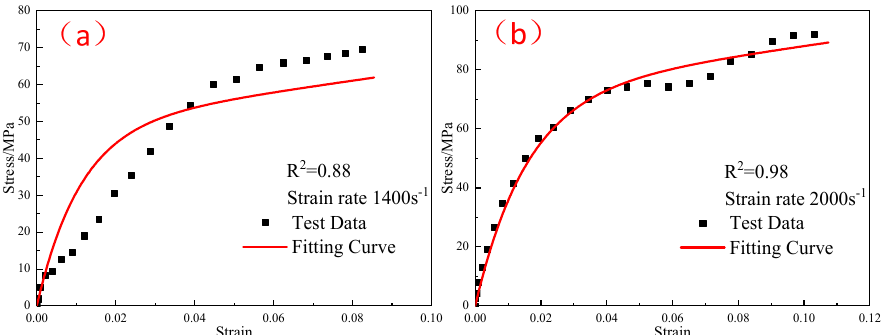
Figure 23. Comparison of the fitting results of the ZWT constitutive model with the experimental results under different strain rates at − 20 °C: ( a ) 1400 s − 1 ; ( b ) 2000 s − 1 .